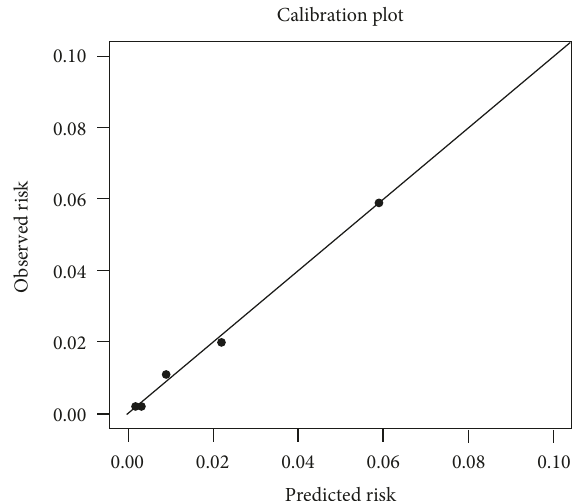
Figure 2: Calibration plot of observed versus predicted risk by quintile. This simplified multivariable model featured good cali- bration with predicted risk similar to observed risk and using the � 1.19, p � 0 . 88). Hosmer–Lemeshow goodness-of fit test ( χ 2 4